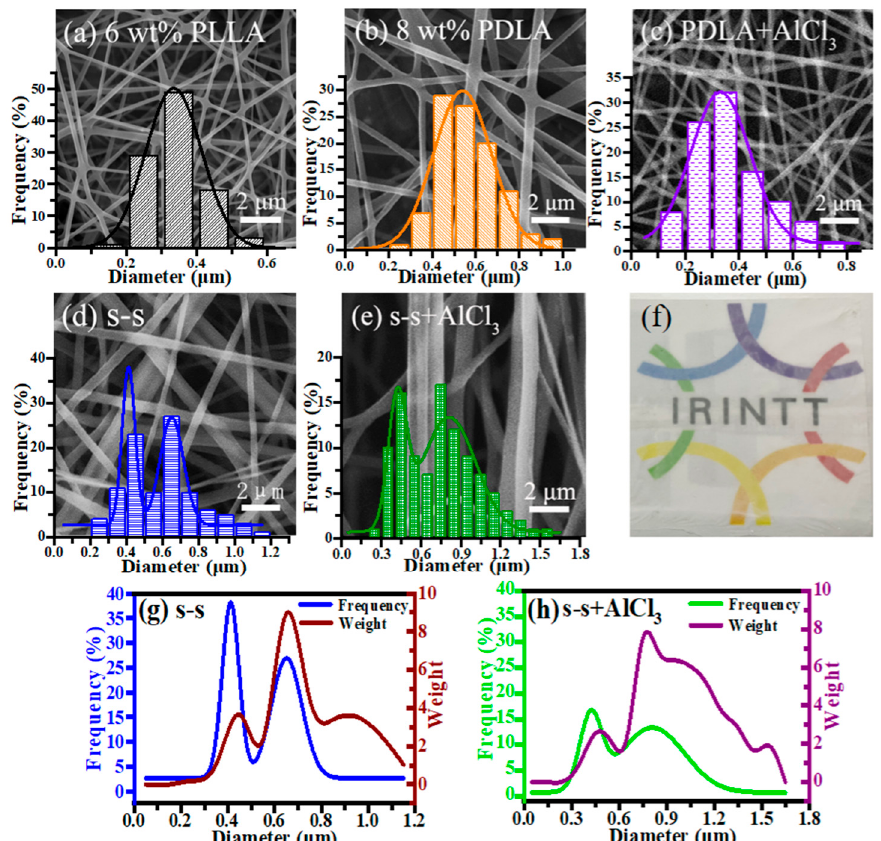
Figure 2. SEM images and nanofiber diameter distributions of ( a ) 6 wt% PLLA, ( b ) 8 wt% PDLA, ( c ) 8 wt% PDLA containing 1 wt% AlCl 3 , ( d ) side-by-side and ( e ) side-by-side containing 1 wt% AlCl 3 nanofibers; ( f ) the transparency of the side-by-side fibers containing 1 wt% AlCl 3 nanofibers; number average and weight average distributions of ( g ) side-by-side and ( h ) side-by-side fibers containing 1 wt% AlCl 3 nanofibers.